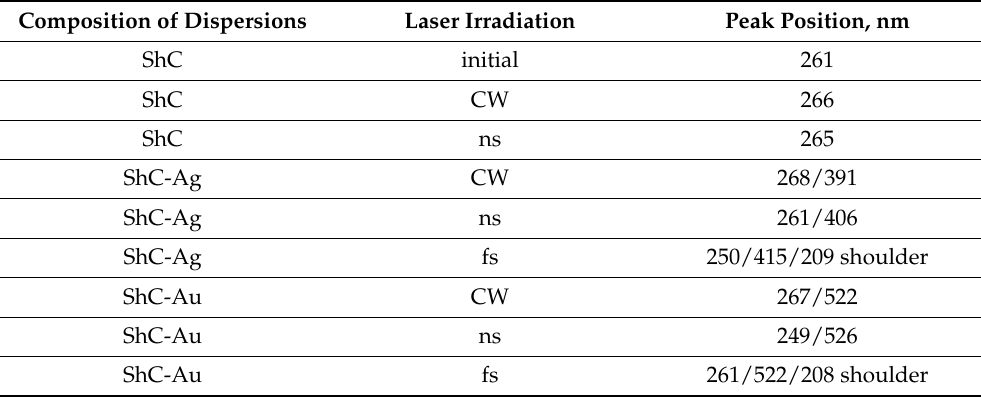
Table 1. Peak positions in the electronic absorption spectra of dispersions of ShC nanoparticles and its